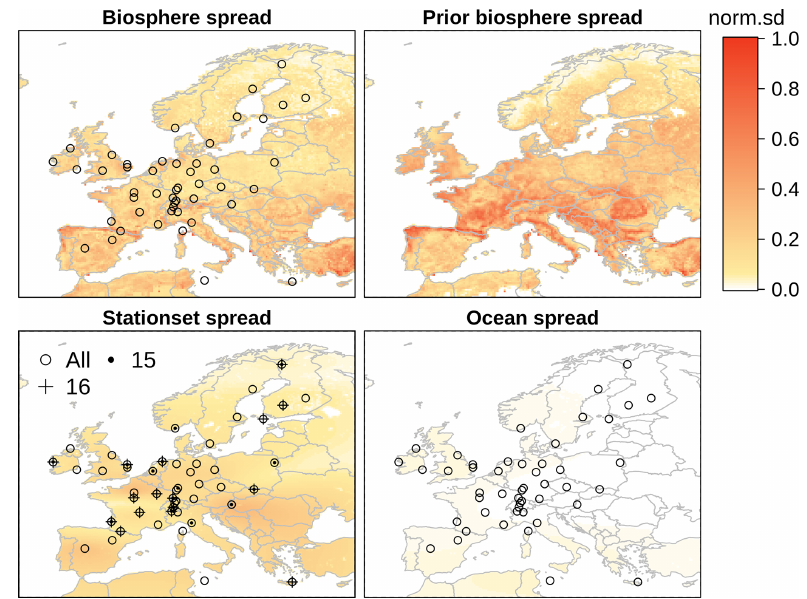
Figure 6. Spatial spread of biosphere, prior, station set, and ocean ensembles. Standard deviation (SD) in the legend is normalised over maximum spread 1.91 × 10 − 4 in units of PgCyr − 1 per grid pixel. Stations used in the station set ensemble are referred to by circles (B0), dots (S1), and the plus symbol (S2).